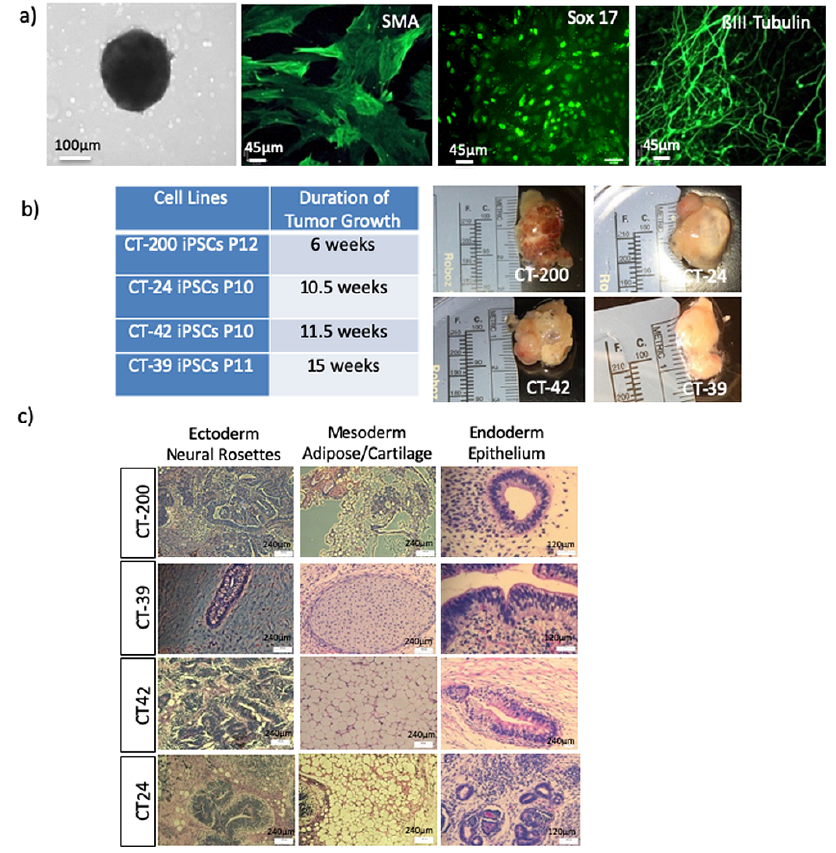
Figure 4. Embryoid body mediated multi-lineage differentiation of CT-MSC iPSCs. ( a ) Phase contrast images show the embryoid bodies (EBs) formed by each of the iPSCs lines (Scale bar = 100 µ m) and immunofluorescence shows the differentiation of the iPSCs into the three germ layers ectoderm (ßIII-Tubulin), mesoderm (smooth muscle actin—SMA) and endoderm (Sox17) in vitro. Scale bar = 45 µ m. ( b ) Reprogrammed transgene-free iPSCs successfully generated subcutaneous teratomas with similar morphology. Representative images of teratomas generated after injecting 1 × 10 7 iPSCs into the hind limb of NOD/SCID mice. Teratomas were excised between 6–15 weeks after the subcutaneous injection of cells. ( c ) The isolated tissue was processed and stained with hematoxylin and eosin (H&E) to identify the three germ layers with neural rosettes (ectoderm), epithelium structures (mesoderm) and adipose and cartilage tissue (endoderm).